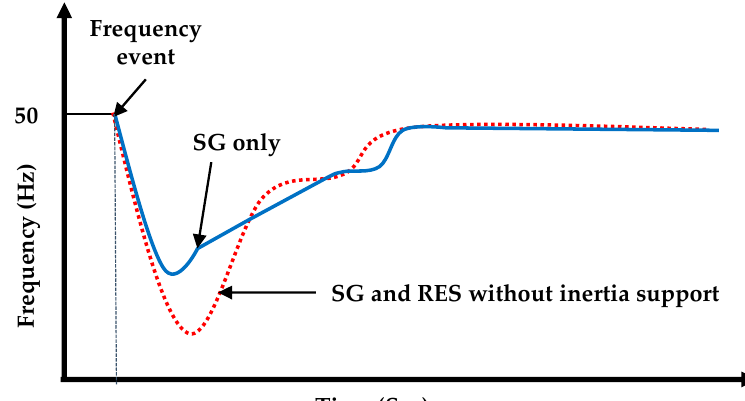
Figure 2. Effect of inertia on frequency [6].